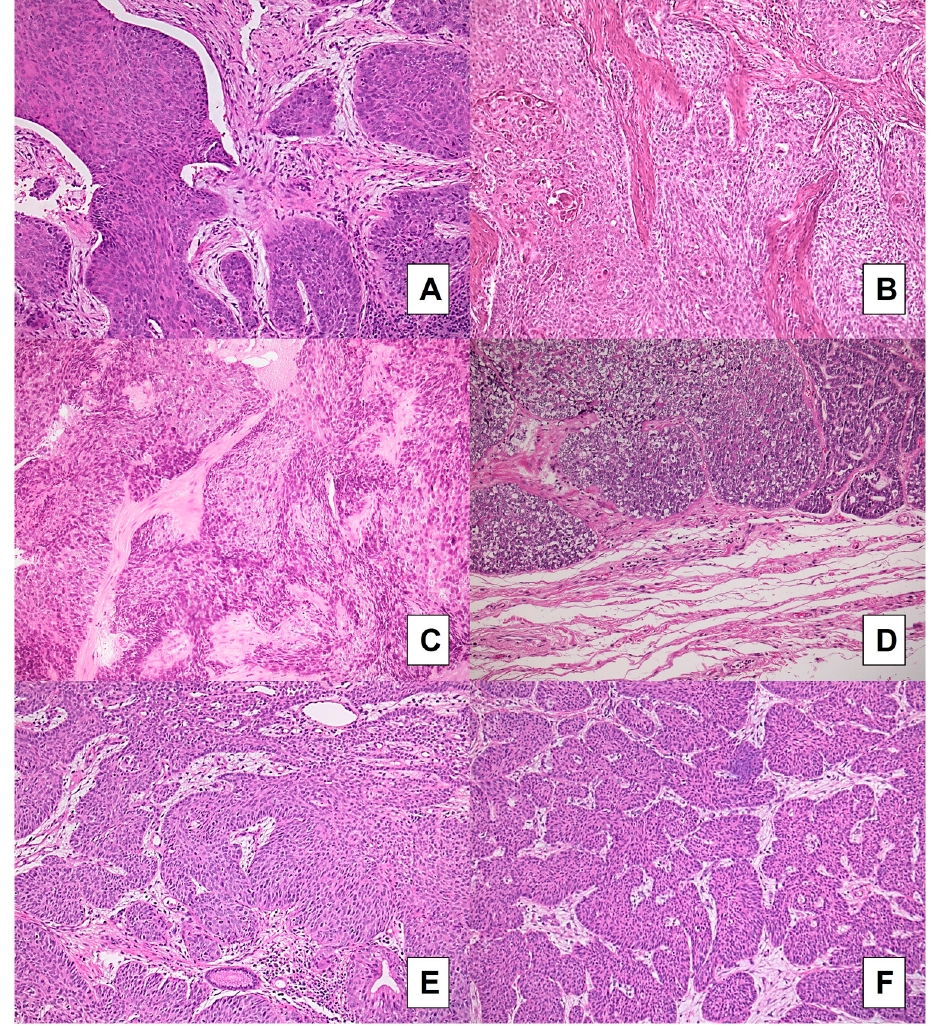
Figure 3. BSCC cases: comparison between preoperative biopsies ( A , C , E ) and matched surgical samples ( B , D , F ). Concordance was very good for the evaluation of tumor budding and for the assessment of large neoplastic nests: nearly all cases showed absence of budding and presence of large nests; a case ( A , B ) showing a fibroblastic stroma in preoperative biopsy ( A ) but a fibrotic stroma type was found in paired resection specimen ( B ); the same fibroblastic stroma was detected in another case in both biopsy ( E ) and matched resection specimen ( F ) (H&E stained slides; original magnification 100×).